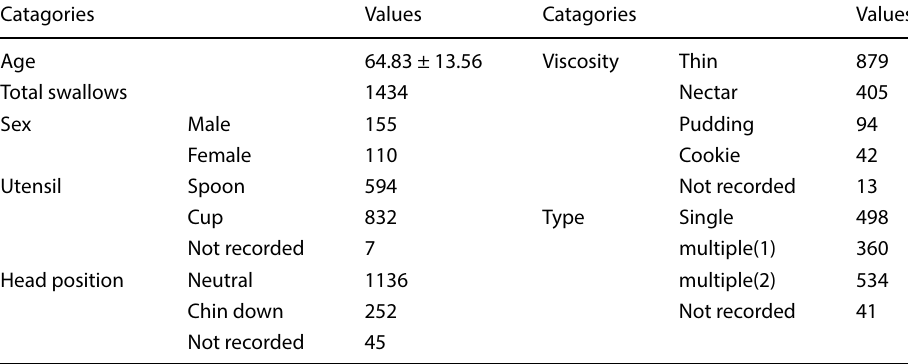
multiple(1) indicates the first swallow in the multiple swallow and multiple(2) indicates the subsequent